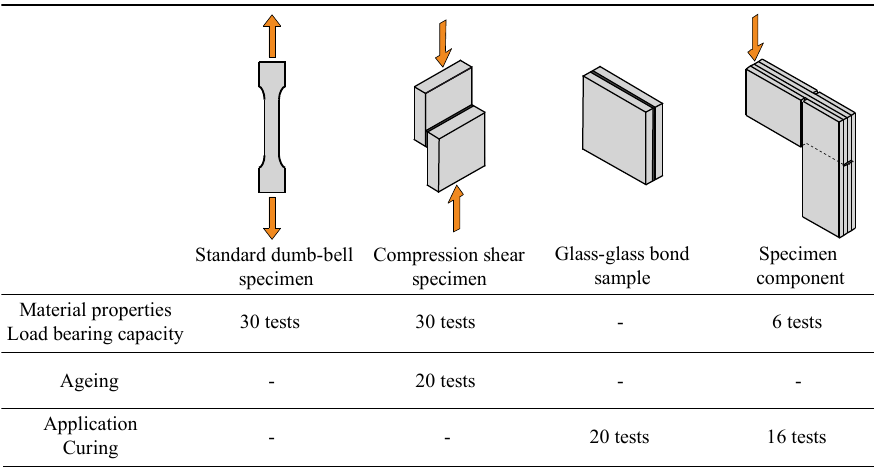
Table 1: Programme of